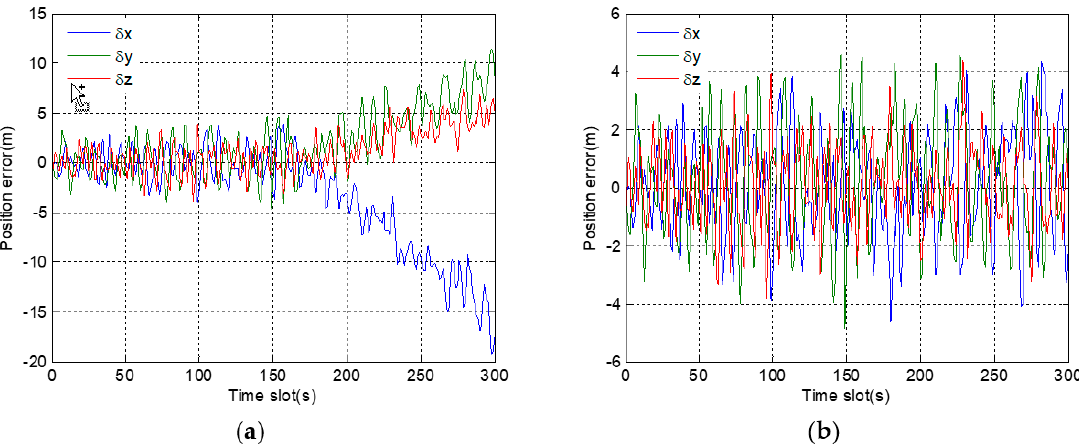
Figure 7. Position errors in 3D direction corresponding to gradual fault: ( a ) before using a robust algorithm; ( b ) after using a robust algorithm.